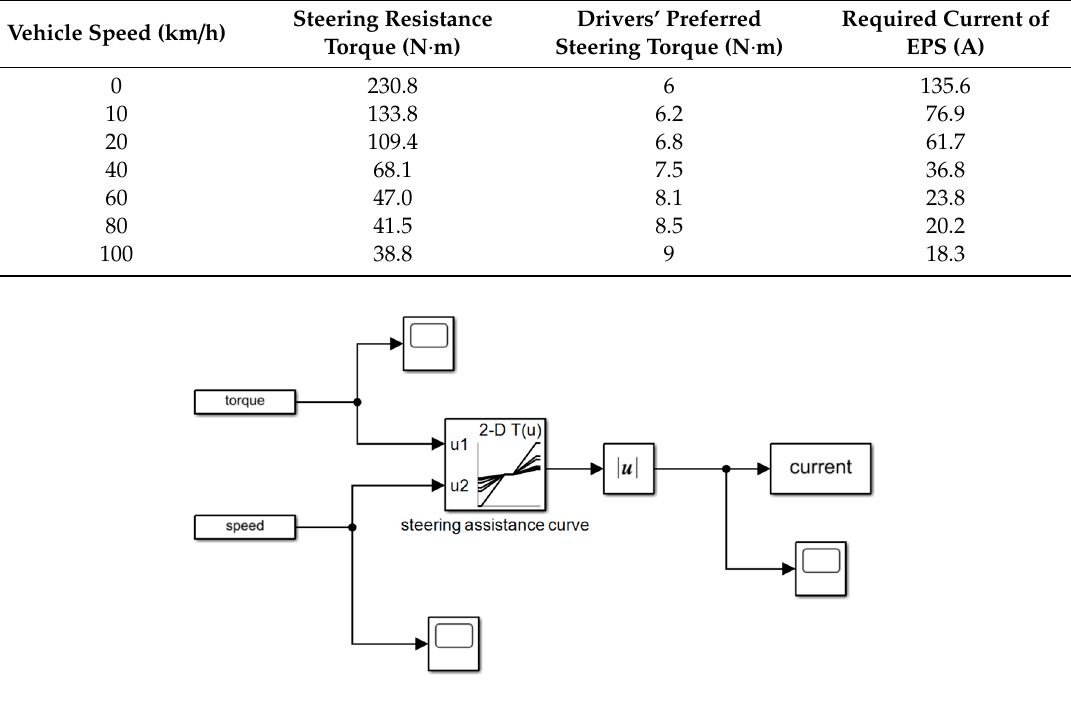
Figure 7. The assist characteristic model of EPS .